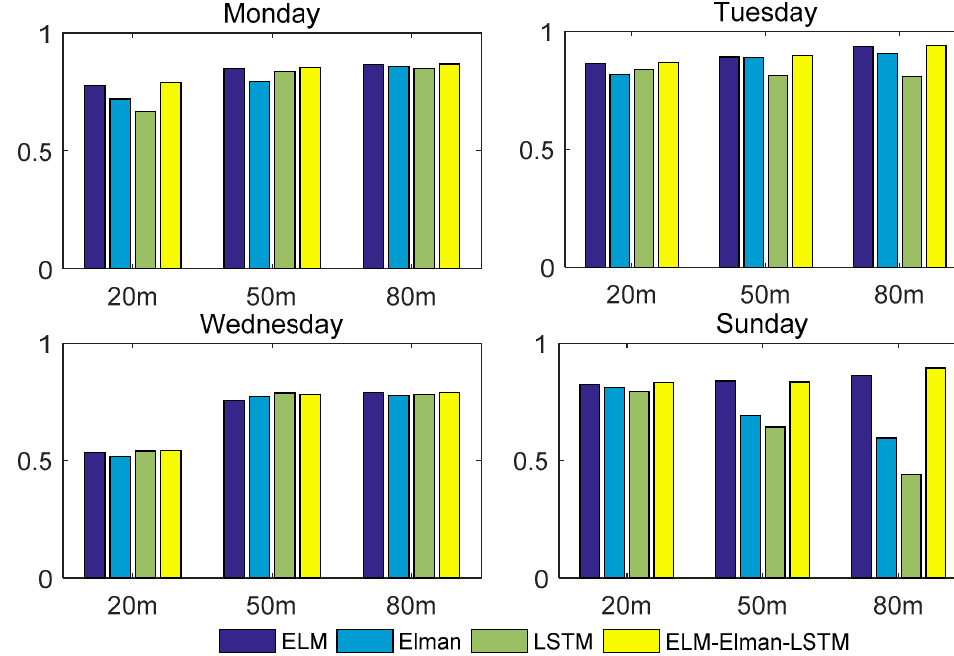
Figure 10. The value of R-squared for the four models.